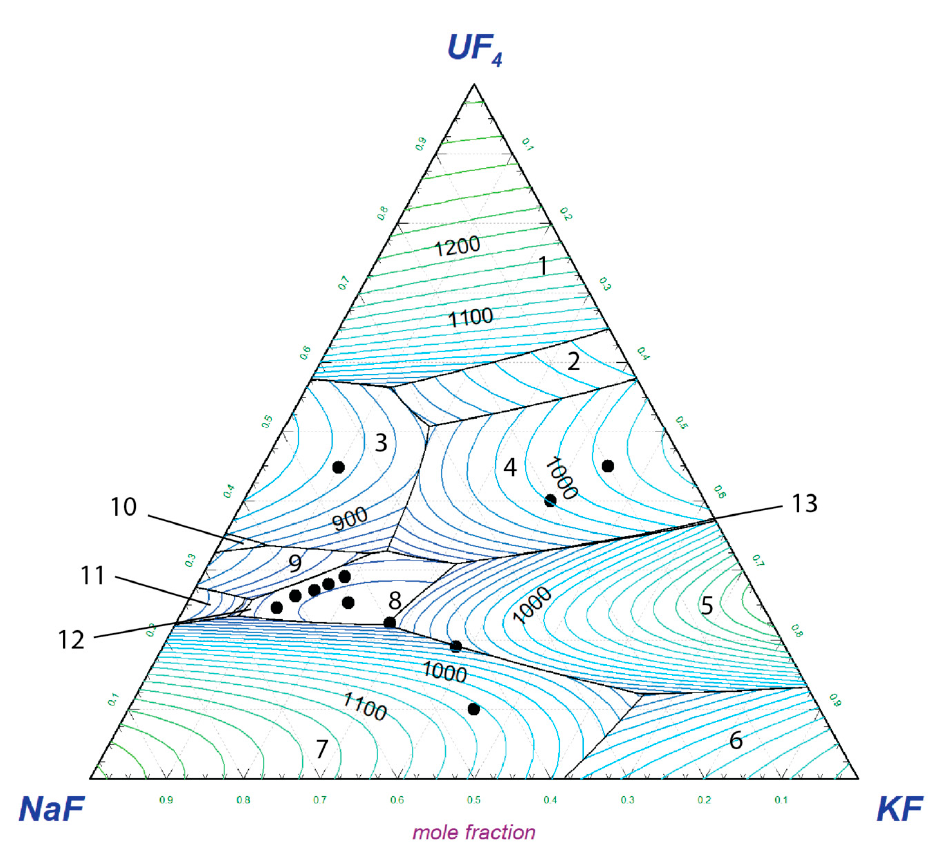
Figure 5. The calculated liquidus projection of the NaF-KF-UF 4 system. Isotherms are calculated in K with intervals of 20 K. The solid circles represent measured compositions and their determined liquidus temperature can be found in Table 5. The calculated primary crystallisation phase fields: (1) UF 4 ; (2) U 2 KF 9 ; (3) Na 7 U 6 F 31 ; (4) K 7 U 6 F 31 ; (5) K 3 UF 7 ; (6) KF_s.s.; (7) NaF_s.s.; (8) Na 2 KUF 7 ; (9) Na 2 UF 6 ; (10) Na 5 U 3 F 17 ; (11) α -Na 3 UF 7 ; (12) β - Na 3 UF 7 ; (13) K 2 UF 6 .